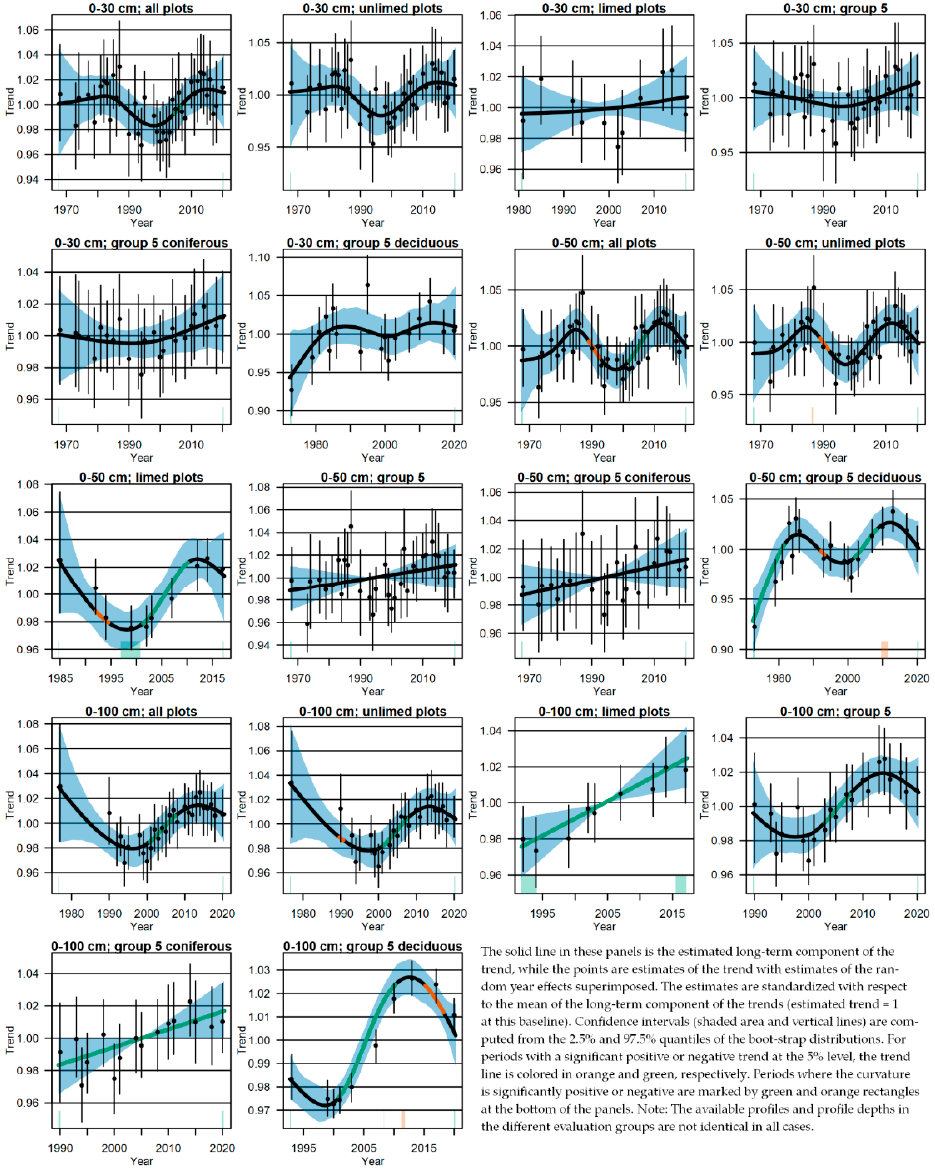
Figure 11. Estimated trends for pH(CaCl 2 ) values in mineral soil for different aggregation depths (0–30 cm, 0–50 cm, and 0–100 cm).